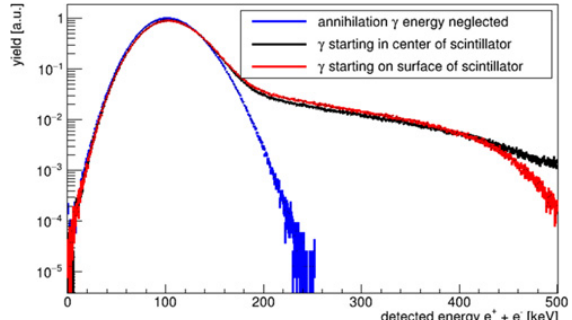
Figure 4. Computation of the effect of the energy deposition of annihilation gammas on a dark matter signal at 100keV (sum of kinetic energy of electron and positron). Plotted is the total detected energy for two positions. Neglecting the gamma energies (blue line) the dark decay signal is underestimated by about